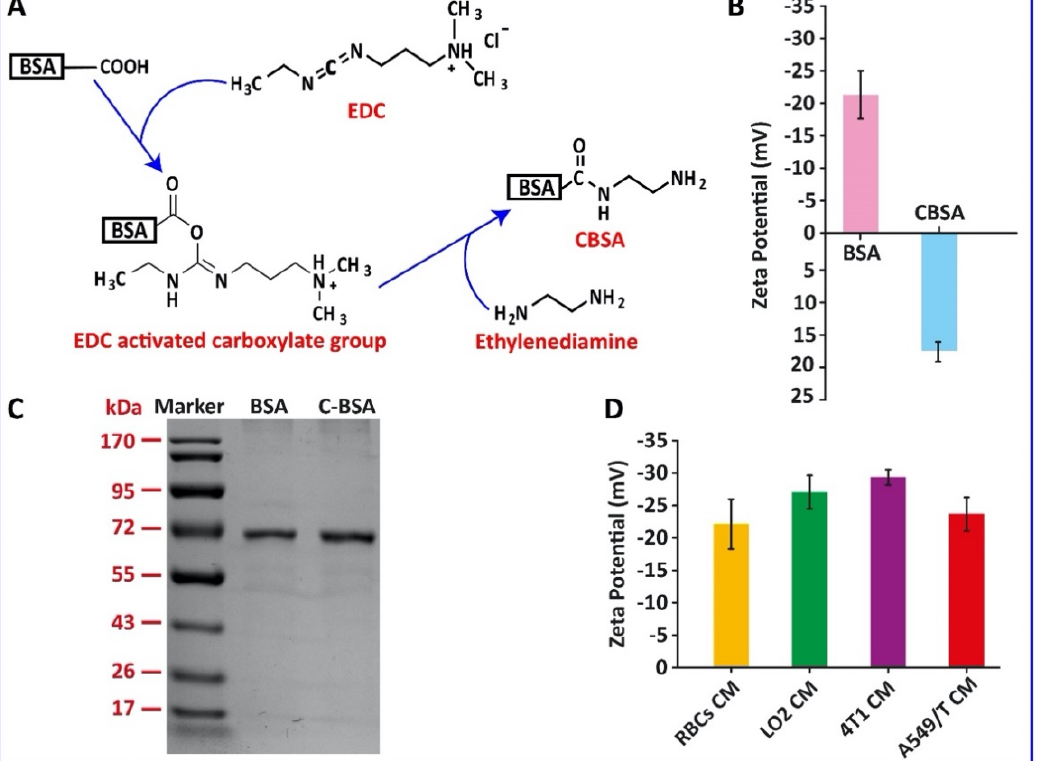
Figure 2. Isolation, preparation, particle size, and PDI of cell membrane vesicles. ( A ) Red blood cells (RBCs), ( B ) LO2, ( C ) 4T1, and ( D ) A549/T.